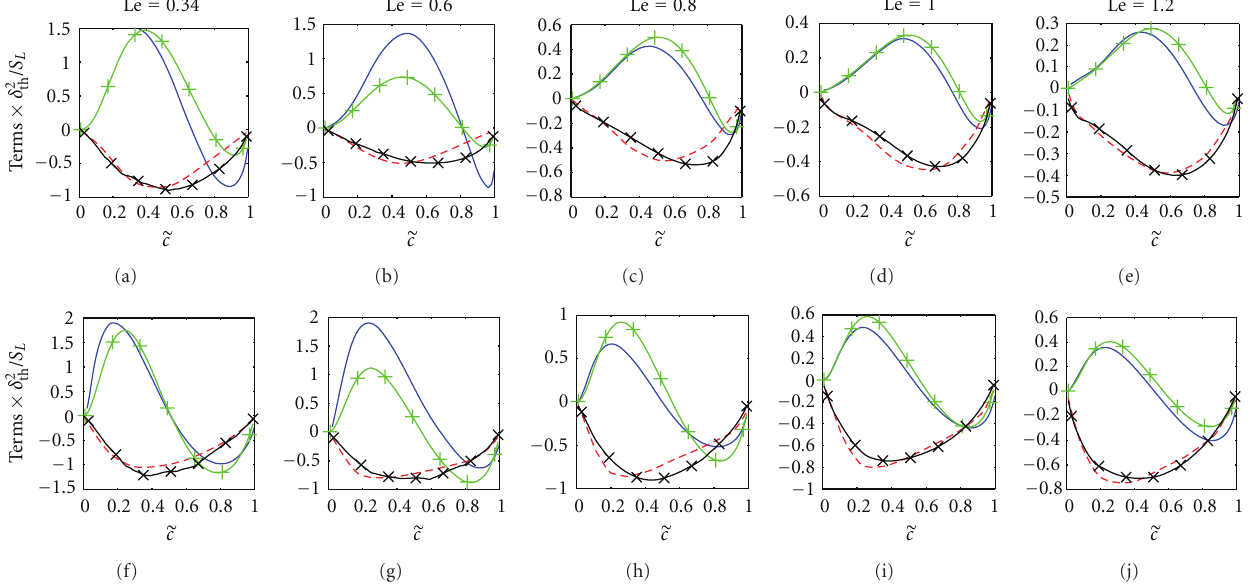
Figure 5: Variations of C sg1 (solid line) and C sg2 (dashed line) conditionally averaged in bins of (cid:2) c across the flame brush along with the predictions of (14) (vertical line) and (16) (crosses line) for Δ = 8 Δ m ≈ 0 . 8 δ th (top row): (a) Le = 0 . 34 (1st column); (b) Le = 0 . 6 (2nd column); (c) Le = 0 . 8 (3rd column); (d) Le = 1 . 0 (4th column); (e) Le = 1 . 2 (5th column) and for filter size Δ = 24 Δ m ≈ 2 . 4 δ th (bottom row): (f) Le = 0 . 34 (1st column); (g) Le = 0 . 6 (2nd column); (h) Le = 0 . 8 (3rd column); (i) Le = 1 . 0 (4th column); (j) Le = 1 . 2 (5th